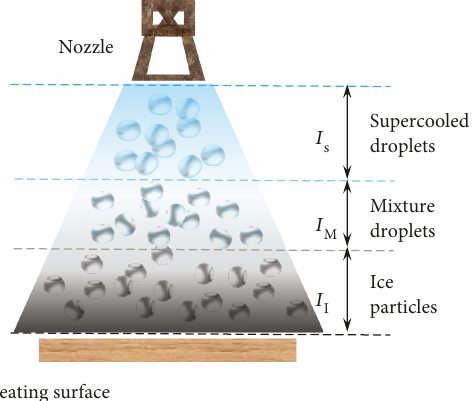
Figure 3: Droplet fl ash evaporation model proposed by Wang et al.